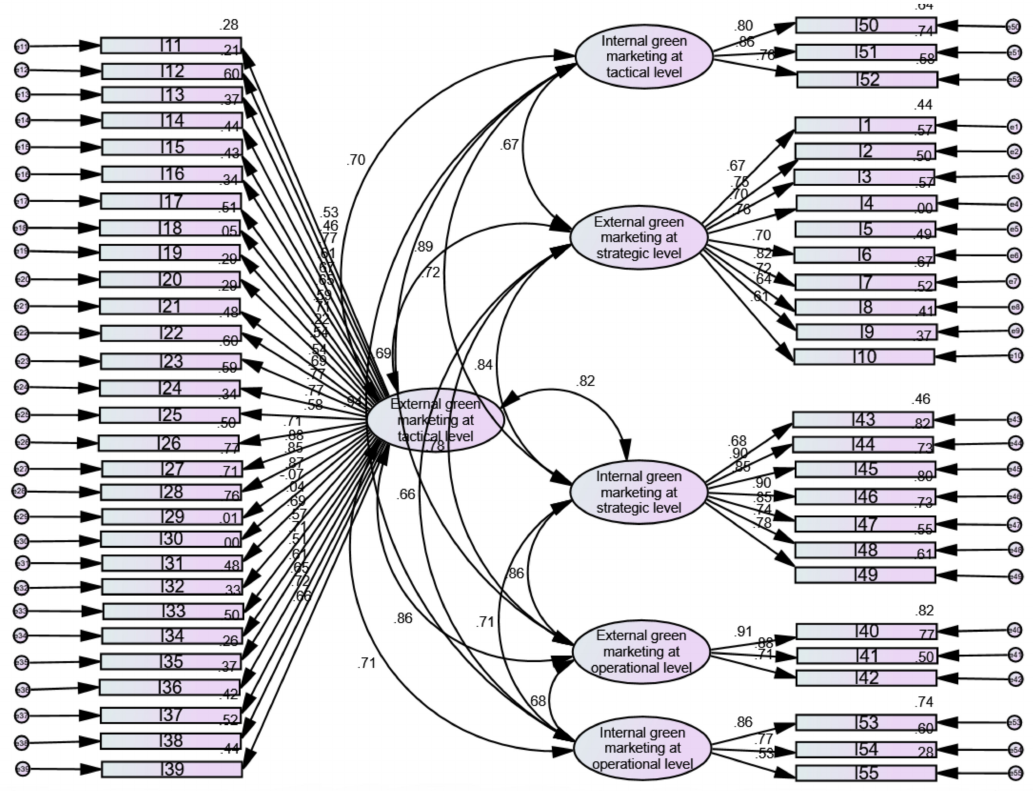
Figure 1. Model 1. The initial confirmatory factor analysis (CFA) model of the Green Marketing Scale